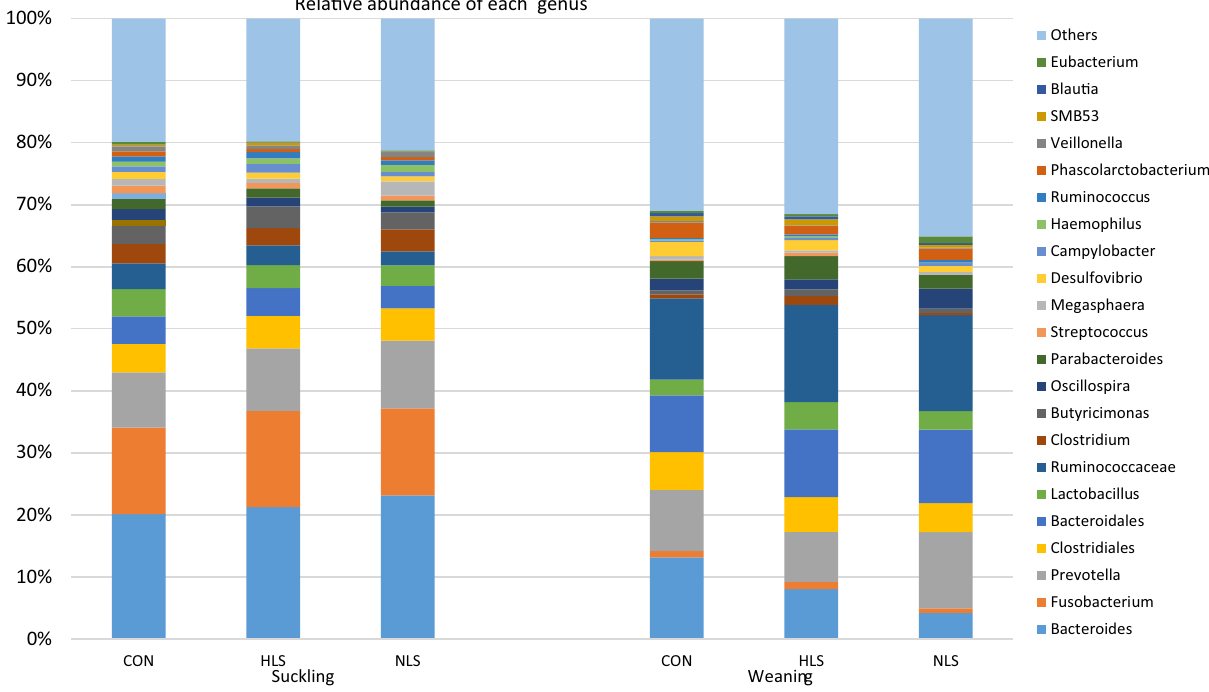
Figure 6. 16S rRNA gene analysis revealed the relative abundance of fecal bacterial community structure at the genus level in piglets orally treated with probiotics Lactobacillus salivarius 144 (HLS), L. salivarius 160 (NLS), or without probiotic (CON) at suckling (d 4) and weaning (d 21)